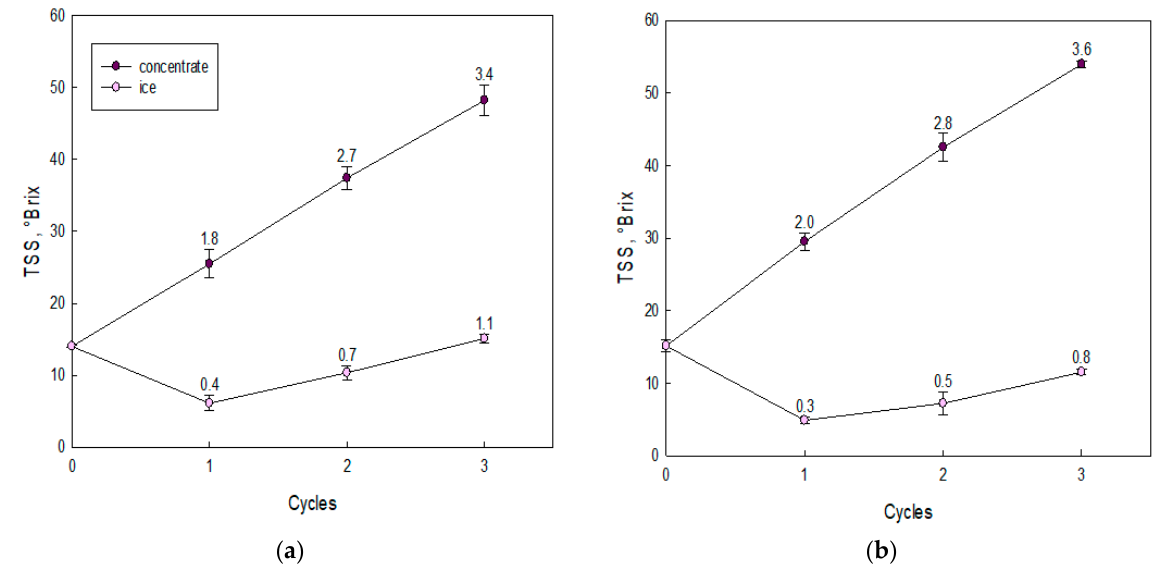
Figure 2. Total soluble solids (TSS) values at each BFC cycle: ( a ) murta juice and ( b ) arrayan juice. The bars represent the standard deviations. The number on the bar is the concentration index (CI), and CI is a dimensionless number that represents the increase in solutes at each BFC cycle (in both cryoconcentrated and ice fractions) with respect to the initial TSS value (C 0 ) (14.0 Brix for murta juice and 15.1 °Brix for arrayan juice), i.e., CI = C c /C 0 , where C c is the TSS value at each cycle.